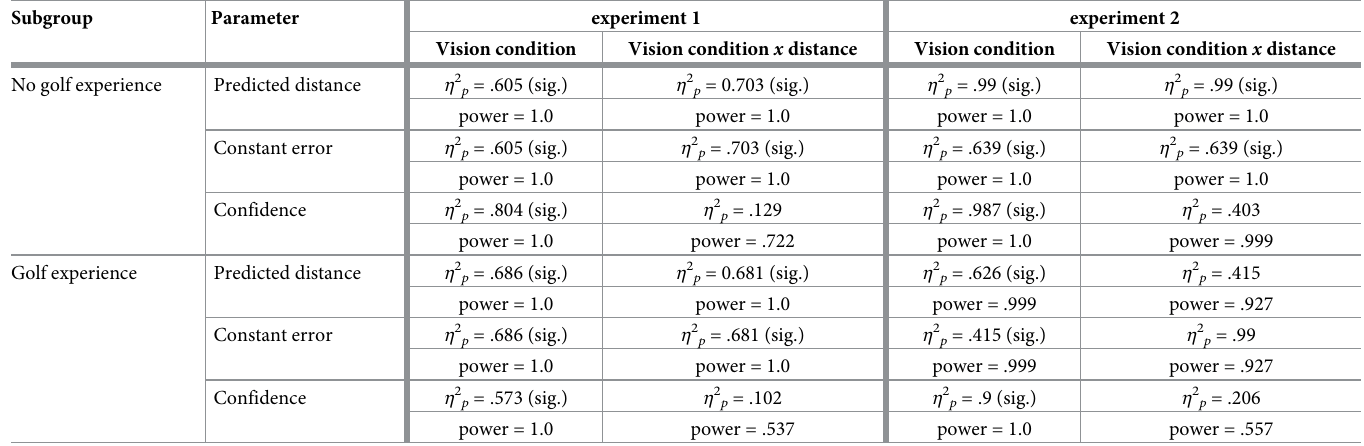
Table 22. Overview of η 2 p , significant, and power of the subgroup analyses in experiment 1 and